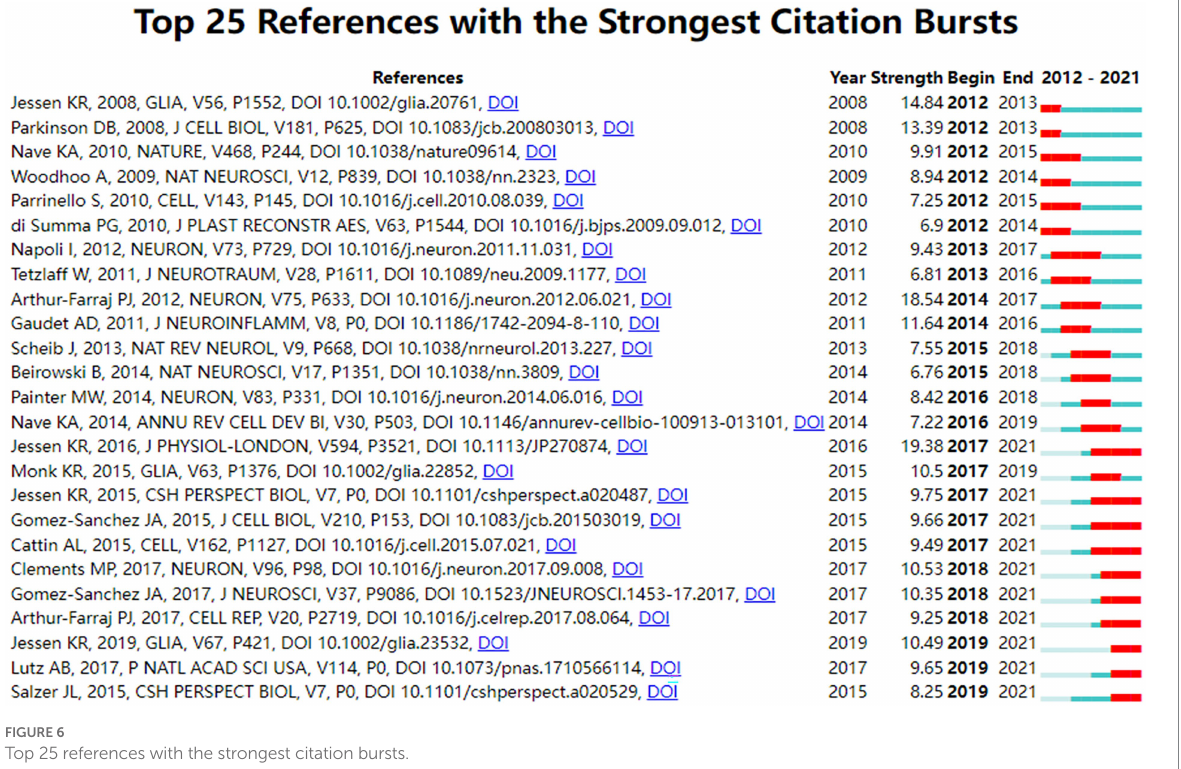
FIGURE 6 Top 25 references with the strongest citation